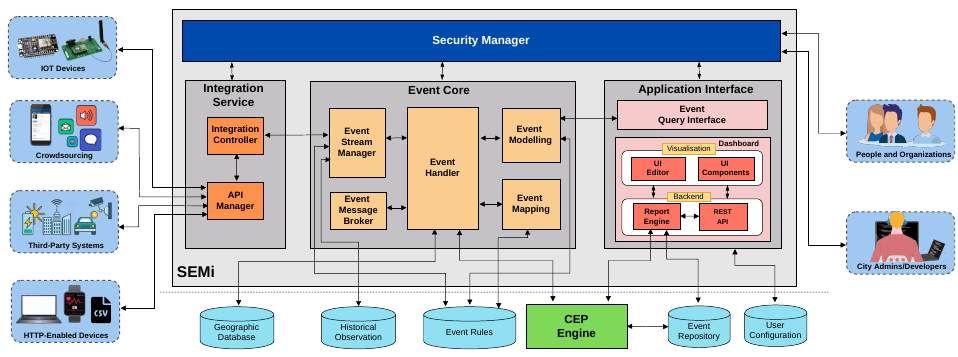
Figure 1. Smart Event-based Middleware (SEMi)